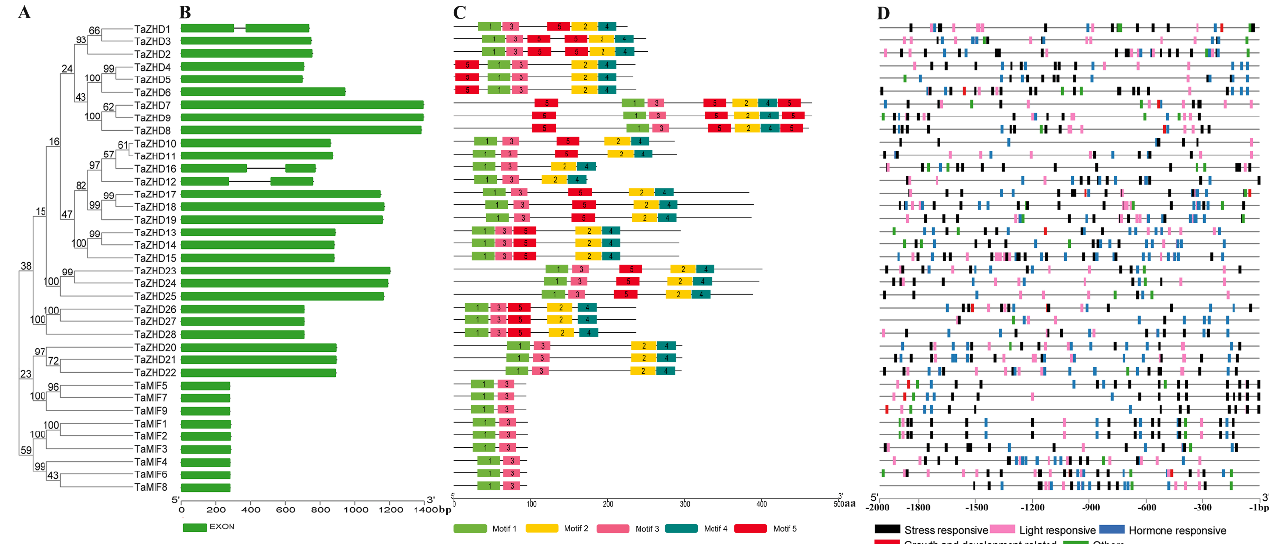
Figure 2. Phylogenetic relationships ( A ), exon-intron structures ( B ), conserved domains ( C ) and cis -elements analysis of TaZF-HD genes. ( B ) Green boxes and black lines indicated exons and introns, respectively. ( C ) Conserved domain compositions of TaZF-HD proteins in wheat. Motif 1 to motif 5 are shown in the different colors. ( D ) Hormone-responsive elements, stress-responsive elements, growth and development related elements, light-responsive elements and other elements with unknown functions are shown by different colors.